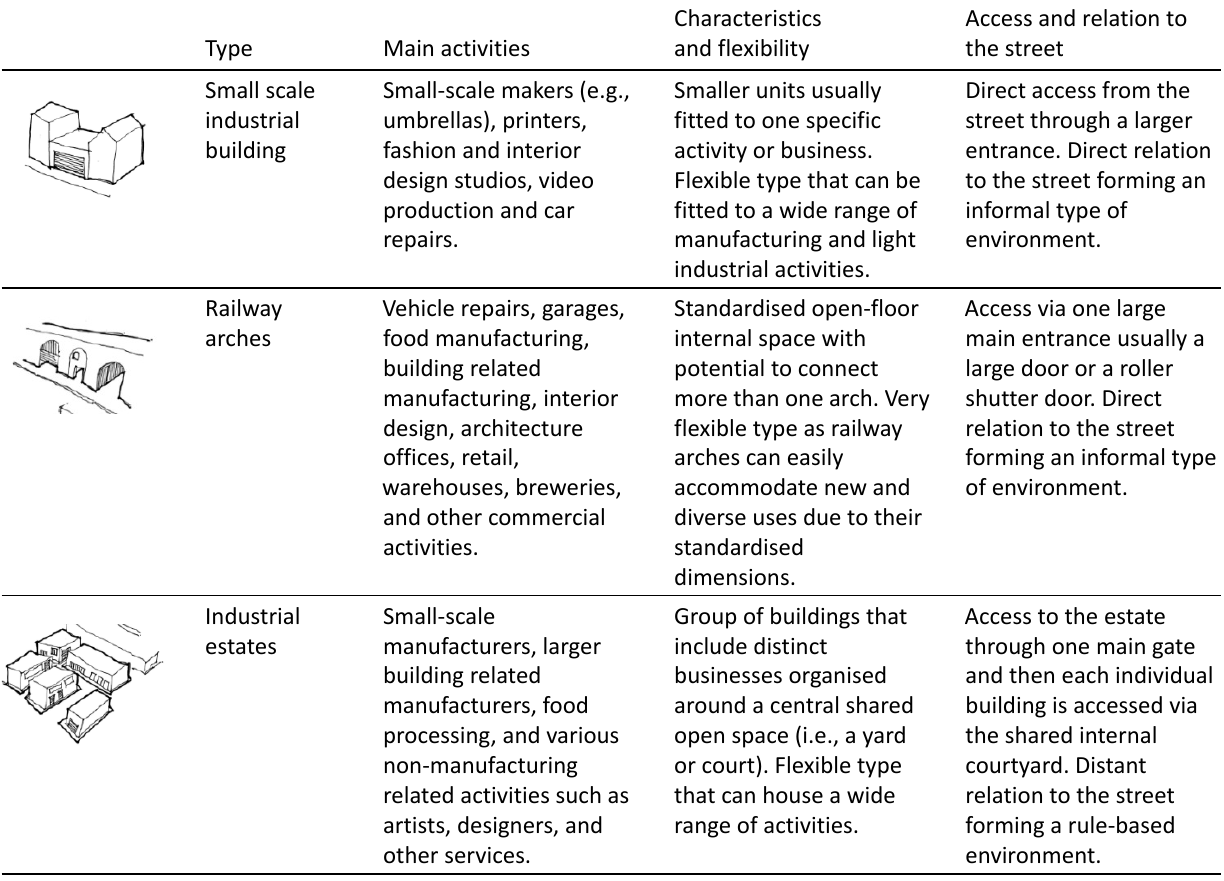
Table 1. Summary of activities, main characteristics, and accessibility of each type of manufacturing building as found in Hackney Mare Street and Old Kent